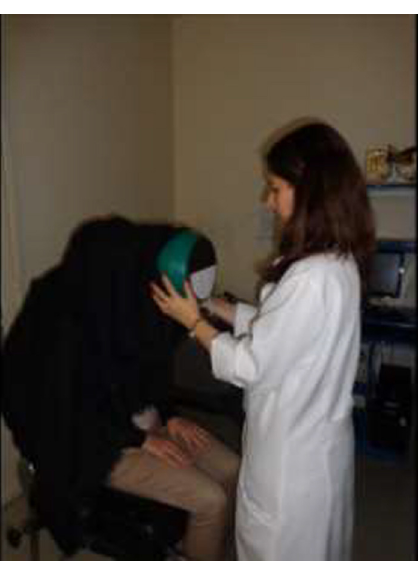
Figure 3 Applying the bucket method.